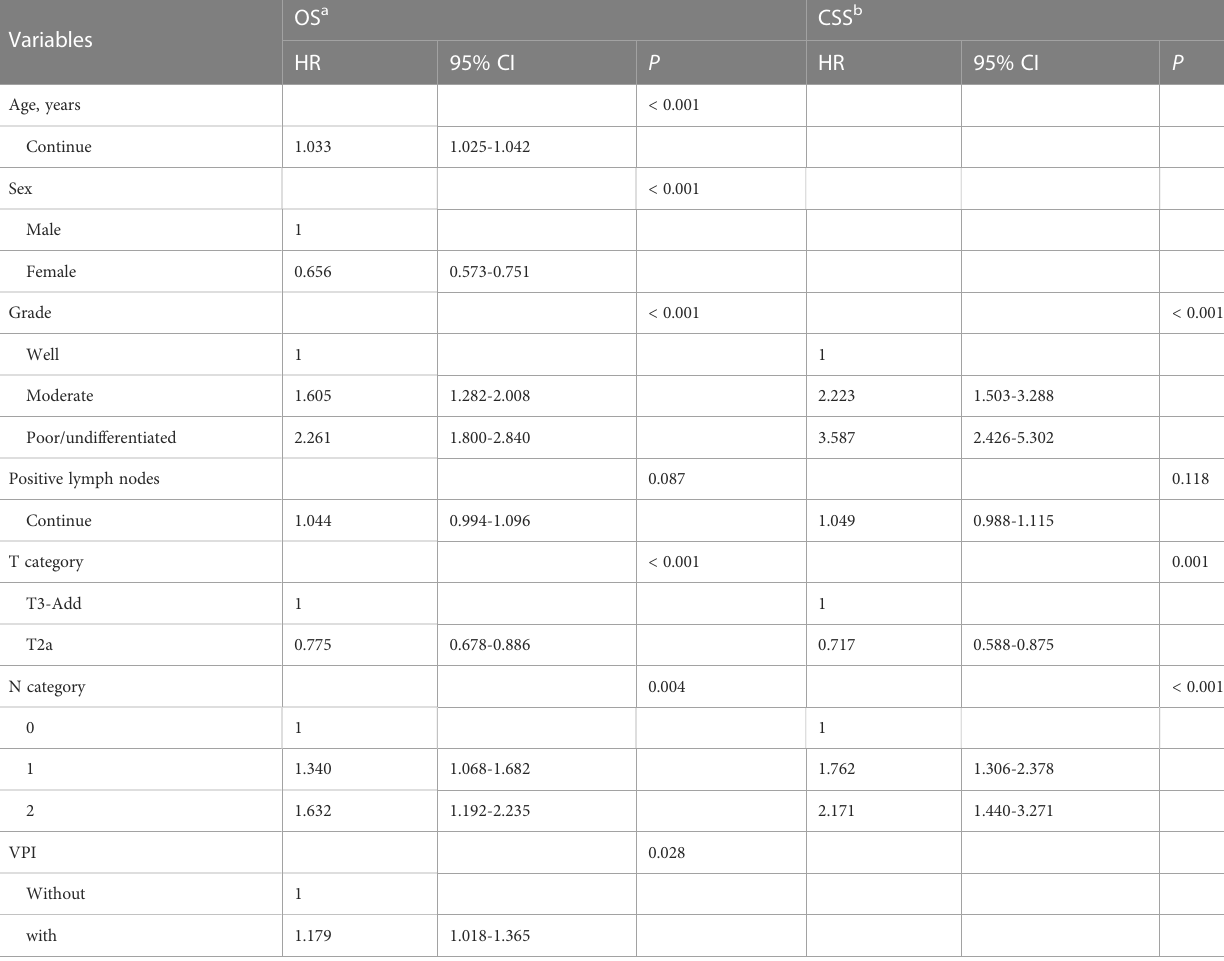
TABLE 2 LASSO-penalized multivariable Cox analysis of the T2a and T3-Add NSCLC patients after PSM.